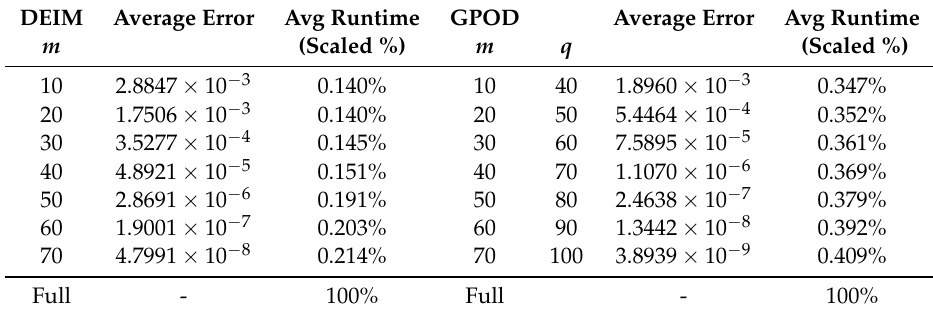
Table 8. [Test 3] Average runtime and average error of the POD-DEIM reduced systems with with parameter values (cid:101) = 0.0105, 0.01, and 0.0095. The POD basis has dimension k = 50 for both POD-DEIM and POD-GPOD